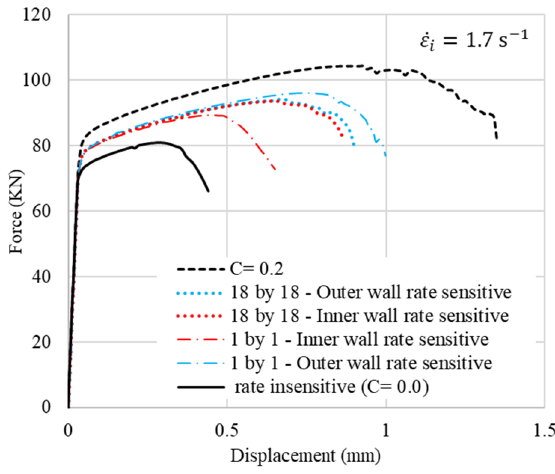
Figure 8. ( a ) 1by1 and ( b ) 18by18 models; rate-sensitive and insensitive at inner and outer walls. The stroke of the top platen, d , is shown above the models.